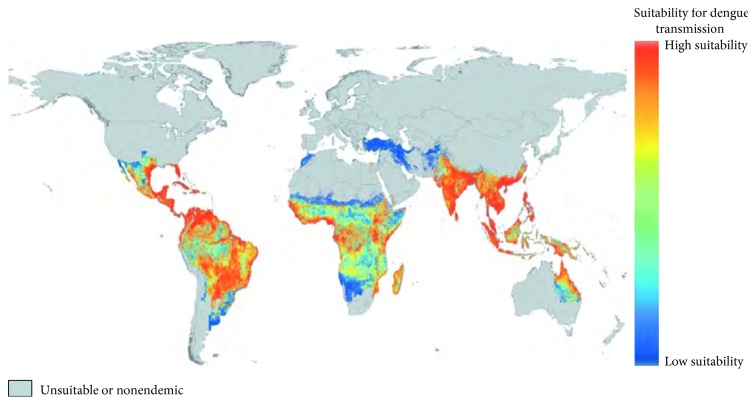
Distribution of global dengue risk [2].